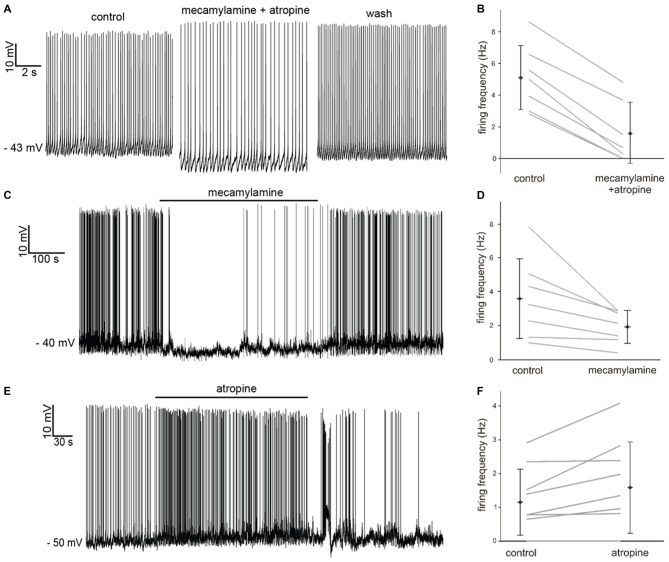
Effects of nicotinic and muscarinic receptor antagonists on LTS interneurons. (A) Co-application of mecamylamine and atropine produced a hyperpolarization accompanied by decreased firing in a LTS interneuron. These effects were reversed after washout. (B) Average spontaneous firing frequency observed in seven LTS interneurons before and after co-application of mecamylamine and atropine. (C) Application of mecamylamine produced a reversible hyperpolarization accompanied by cessation of spontaneous firing in a LTS interneuron. (D) Average spontaneous firing frequency observed in seven LTS interneurons before and after co-application of mecamylamine. (E) Application of atropine produced a depolarization and an increase in spontaneous firing frequency in a LTS interneuron. These effects were reversed after washout. (F) Average spontaneous firing frequency observed in nine LTS interneurons before and after co-application of atropine. Two LTS interneurons did not fire in either condition.